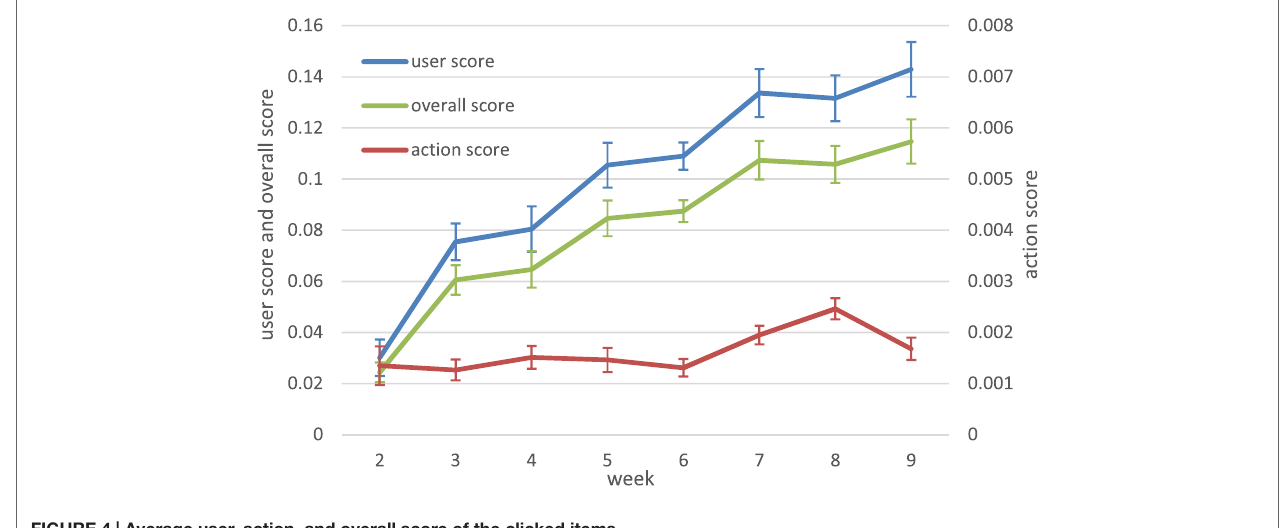
FigUre 4 | average user, action, and overall score of the clicked items .